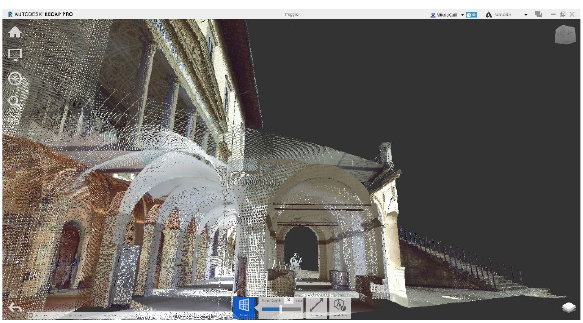
Figure 1: post processing of the point cloud of the entrances of the villa in